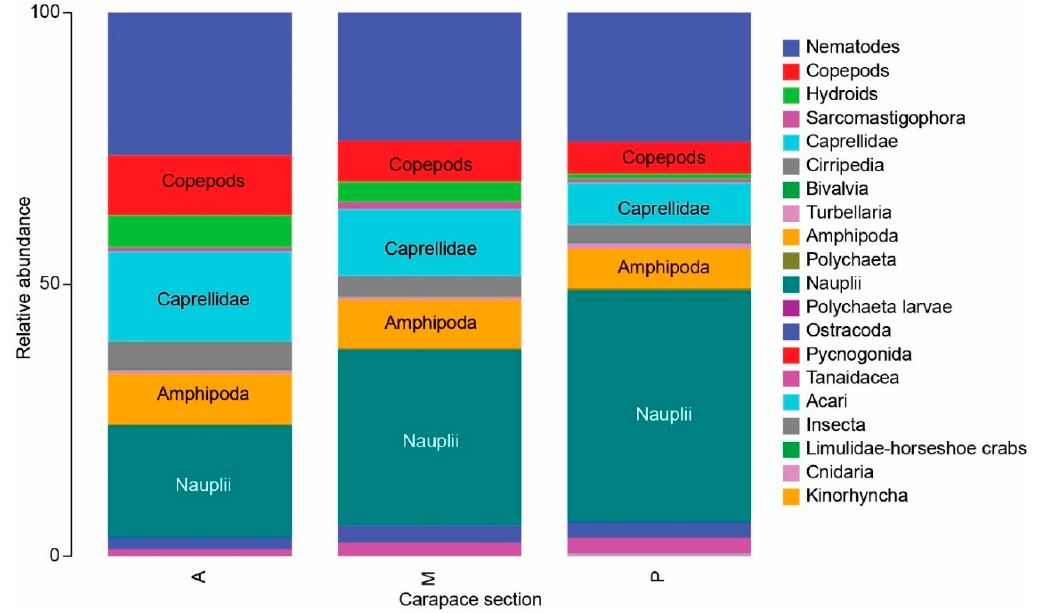
Figure 2. Relative abundance of meiofauna higher taxa and larval forms per carapace section. A: anterior section, M: middle section, P: posterior section.